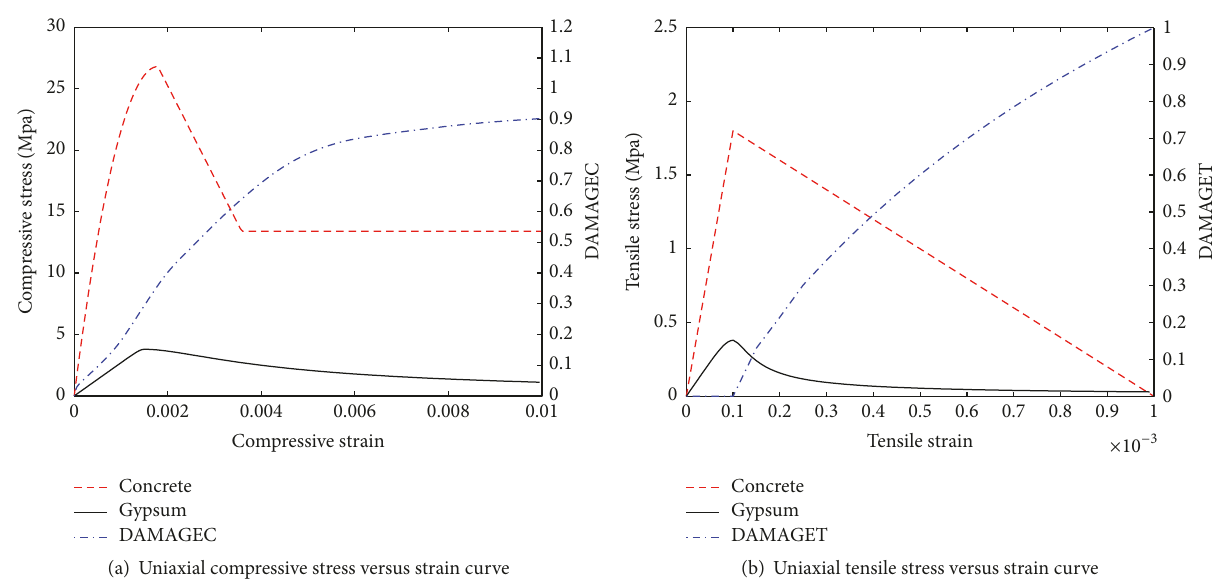
Figure 5: The time history and response spectrum of applied seismic acceleration.